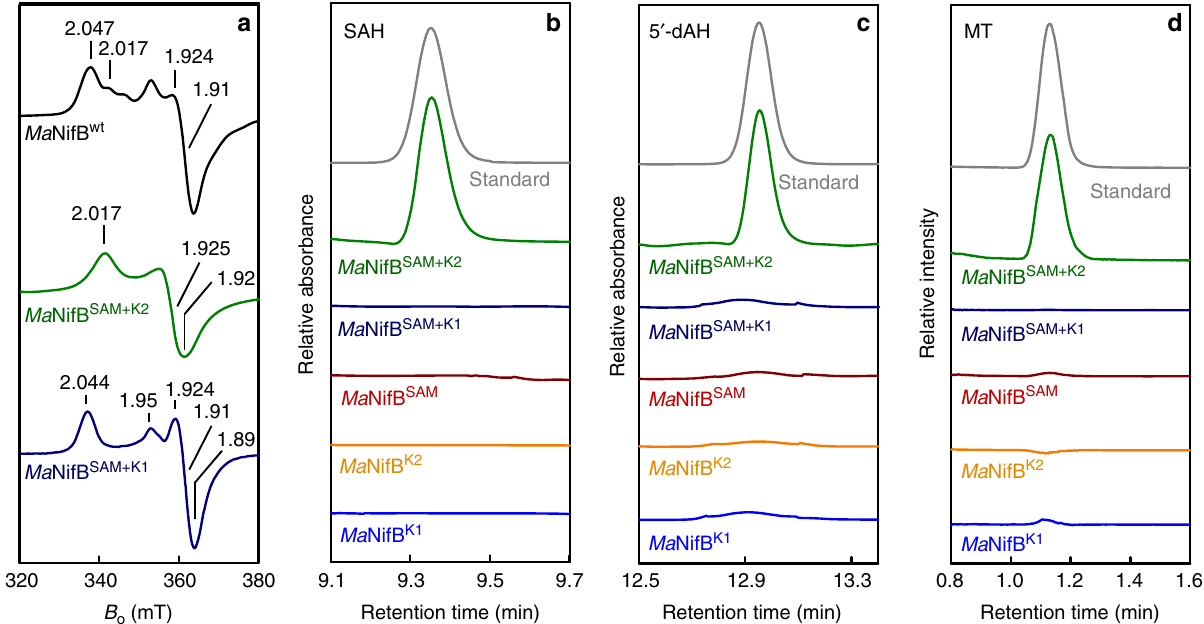
Fig. 3 Spectroscopic and functional properties of the cluster modules in Ma NifB. a EPR spectra of the synthetic [Fe 4 S 4 ] cluster-reconstituted wild-type Ma NifB ( Ma NifB wt , black) and Ma NifB variants carrying SAM plus K2 ( Ma NifB SAM + K2 , green) and SAM plus K1 ( Ma NifB SAM + K1 , dark blue) modules, respectively. b , c HPLC elution pro fi les of SAH ( b ) and 5 ′ -dAH ( c ) standards (gray), and those of SAM incubated with Ma NifB variants carrying K1 ( Ma NifB K1 , light blue), K2 ( Ma NifB K2 , orange), SAM ( Ma NifB SAM , brown), SAM plus K1 ( Ma NifB SAM + K1 , dark blue), and SAM plus K2 ( Ma NifB SAM + K2 , green) modules, respectively. d GC analyses of the methanethiol (MT) standard (gray) and acid-quenched incubation mixtures containing SAM and Ma NifB variants carrying K1 ( Ma NifB K1 , light blue) and K2 ( Ma NifB K2 , orange), SAM ( Ma NifB SAM , brown), SAM plus K1 ( Ma NifB SAM + K1 , dark blue), and SAM plus K2 ( Ma NifB SAM + K2 , green) modules, respectively. The CW EPR ( a ), HPLC ( b , c ), and GC ( d ) experiments were performed three times each. Representative results are shown in the fi gure. See Supplementary Table 1 for Fe contents and protein concentrations of EPR